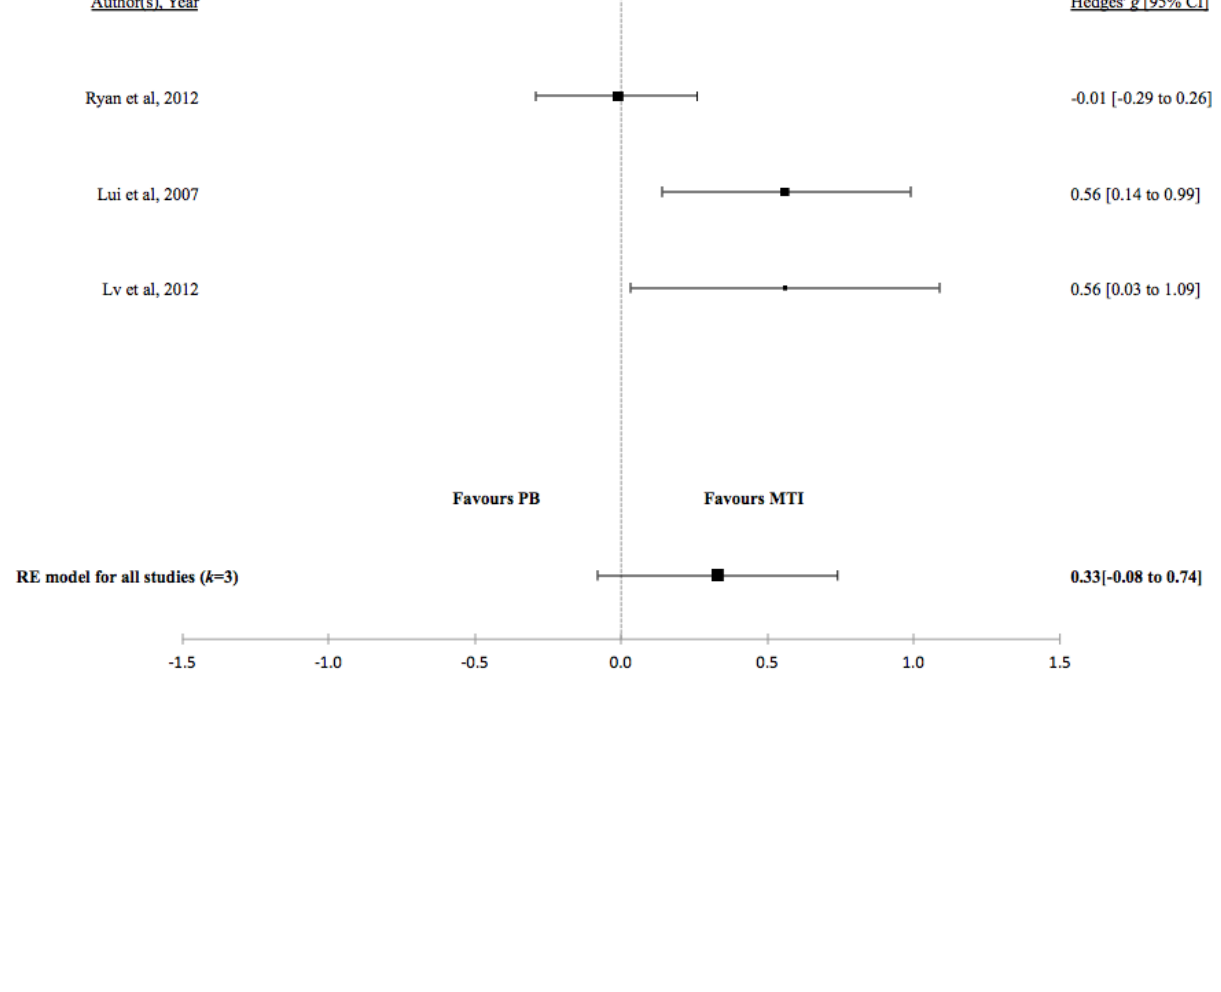
Figure 8. Forest plot of the standardized mean difference in quality of life between MTI and paper-based group (PB). MTI: mobile technology